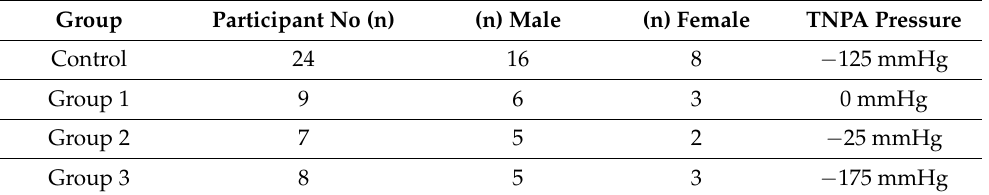
Figure 1. Potential projection of direct perforator vessels at the skin (spotted rings) as they could be detected by thermography as so-called hot spots. ( A ) “Hot spot” projection: circled areas show enhanced heat pattern over perforating vessels and can be visualized by thermography. ( B ) Subcuta- neous perforator vessels branching into skin. ( C ) Axial submuscular blood vessels. Table 1. Overview of study groups: distribution of participants and TNP values for correspond- ing